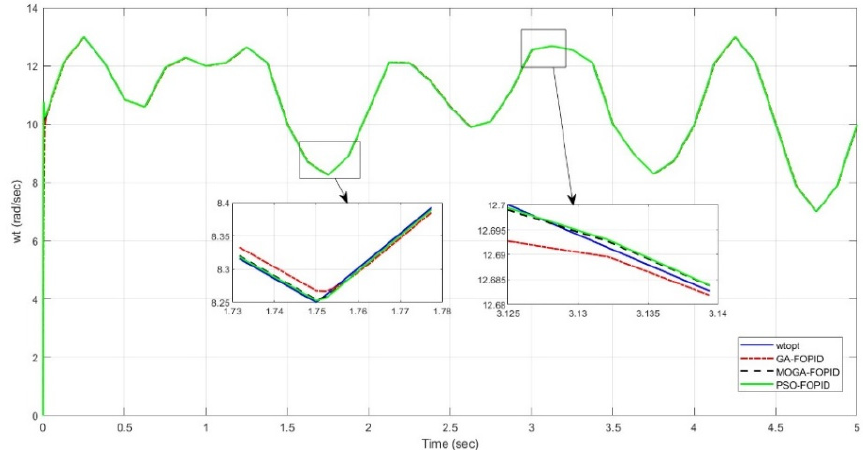
Figure 8. The speed response of the wind turbine model for a sinusoidal reference.